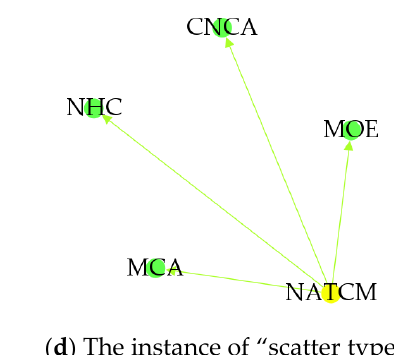
Figure 4. The node relationship figure of the out-degree. ( a ) The representative result of “full connection type” (taking the NHC node as an example), ( b ) the representative result of “wide-range connection type” (taking the MCA node as an example), ( c ) the representative result of “small-range connection type” (taking the NHSA node as an example), and ( d ) the representative result of “scatter type” (taking the NATCM node as an example). In Figure 3, the circle indicates the government department node in the HnICN, and the line segment between any two circles denotes the connection of these two